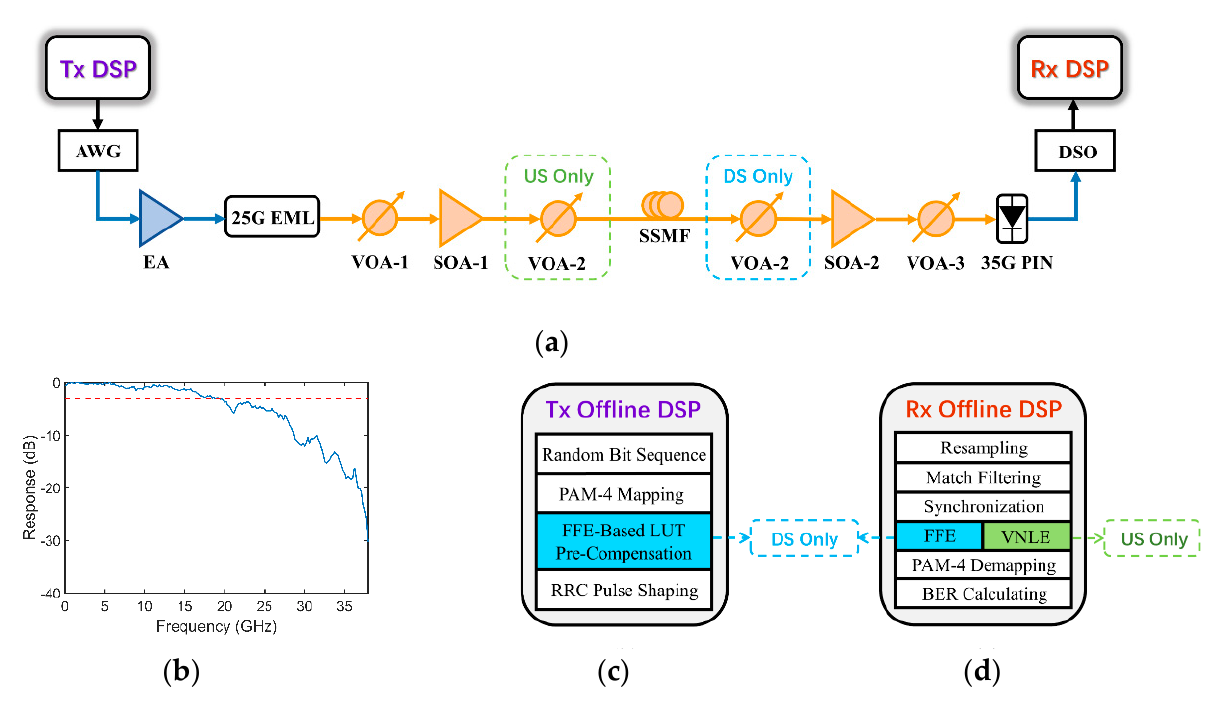
Figure 2. ( a ) Experimental setup for 100 Gb/s/ λ PAM-4 PON; Frequency response of the system ( b ); Tx ( c ) and Rx ( d ) side offline DSP flow, respectively.